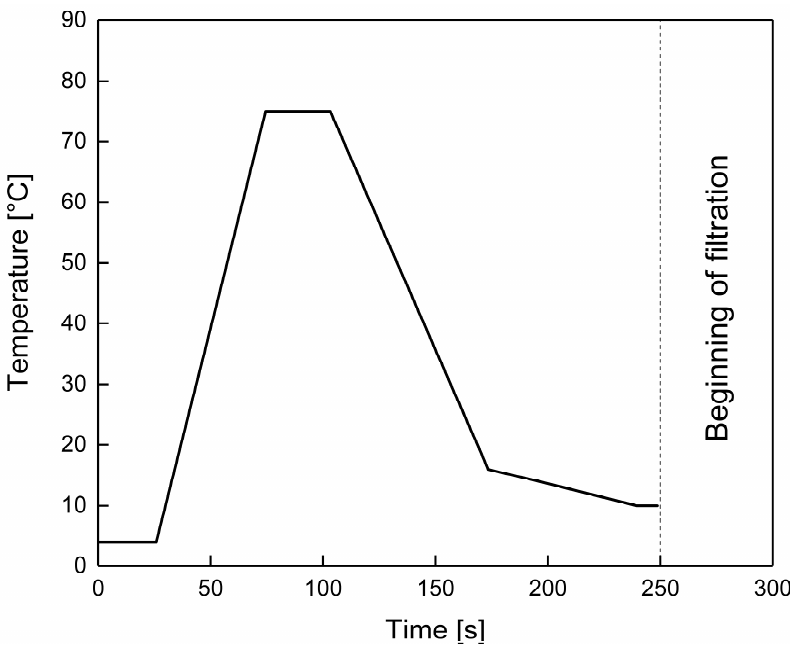
Figure 1. Temperature–time profile for the pre-heating step prior to the filtration.